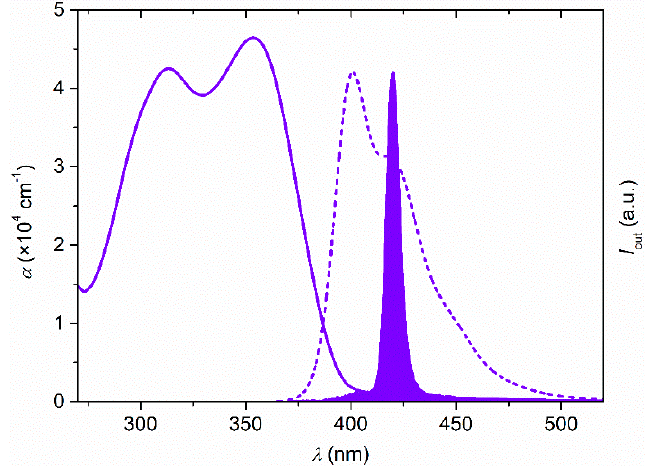
Figure 4. Absorption coefficient, α , PL intensity and ASE spectra of a 30 wt% TPD doped PS film: Absorption coefficient (solid line, left axis), PL (dashed line, right axis), and ASE, (filled area, right axis).